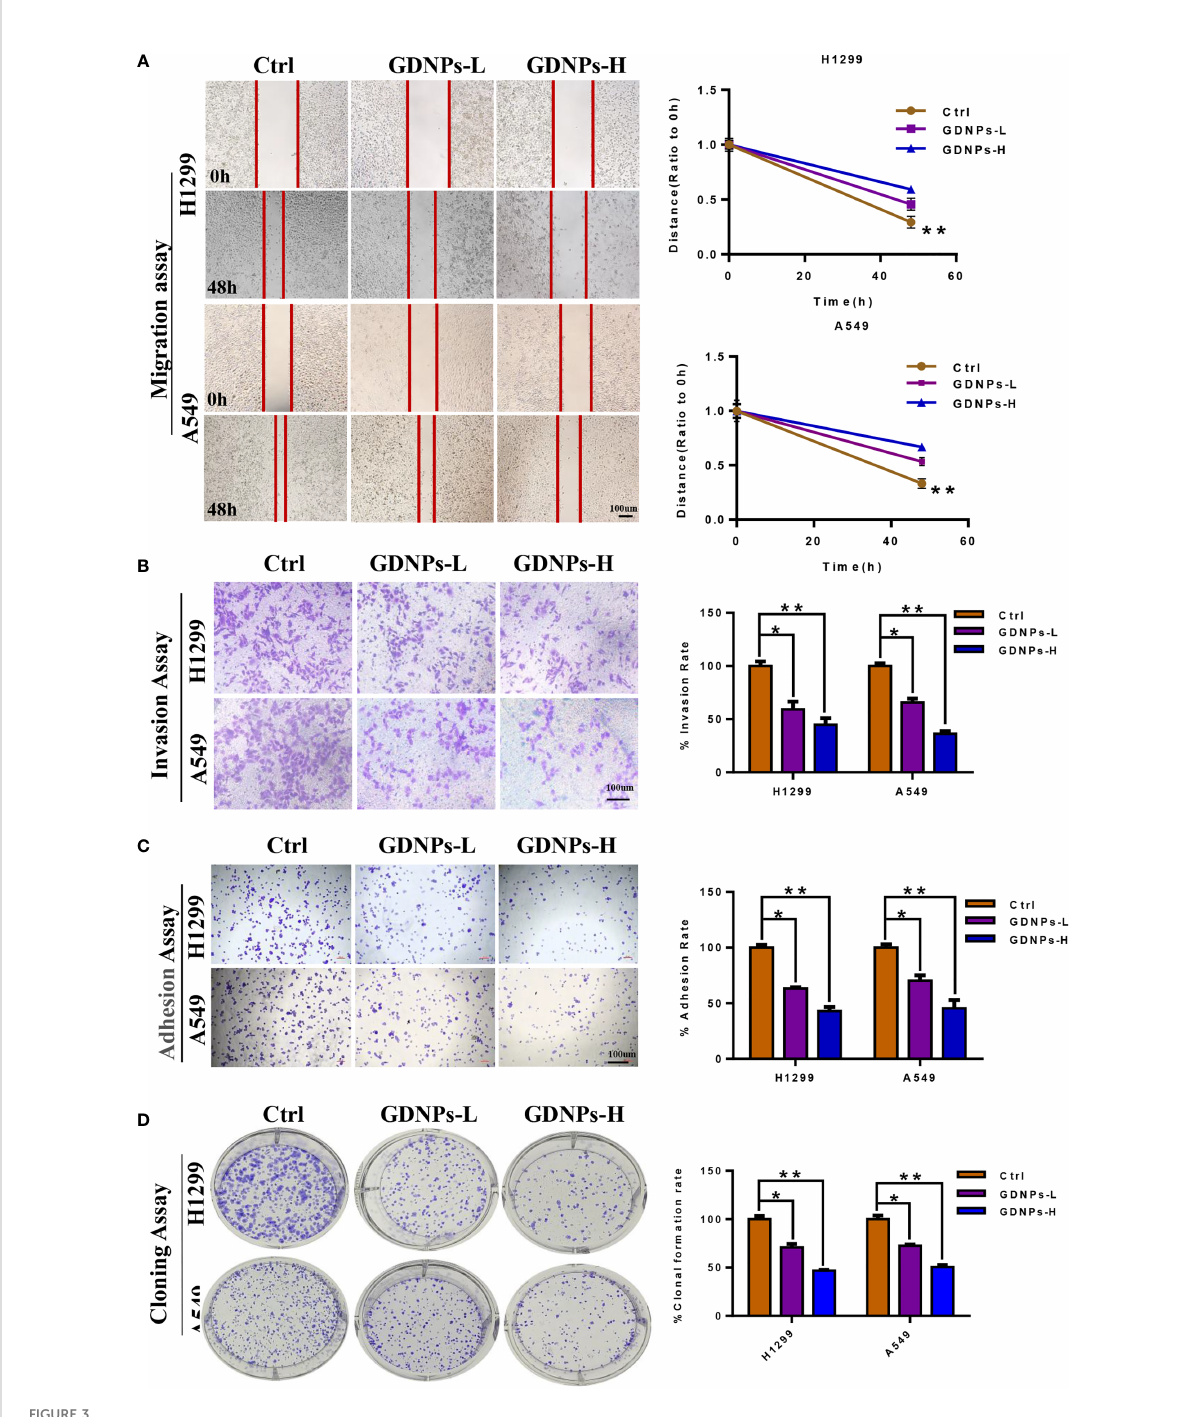
FIGURE 3 GDNPs inhibited human NSCLC cell migration, invasion, and colony formation. (A) GDNPs signi fi cantly inhibited migratory abilities of A549 and H1299 cells as compared with the untreated group cells as measured via the wound healing assay. (B) GDNPs signi fi cantly inhibited invasion abilities of two lung cancer cell lines as compared with the untreated group cells as measured vis the transwell assay. (C) GDNPs inhibited the adhesion of A549 and H1299 cells. (D) GDNPs inhibited colony formation by A549 and H1299 cells. GDNPs-H designates GDNPs at high concentration (60 m g/mL) and GDNPs-L designates GDNPs at low concentration (30 m g/mL). Statistical results are summarized in the right panel. Data are presented as the mean ± SD of three experiments (*P < 0.05 and **P <